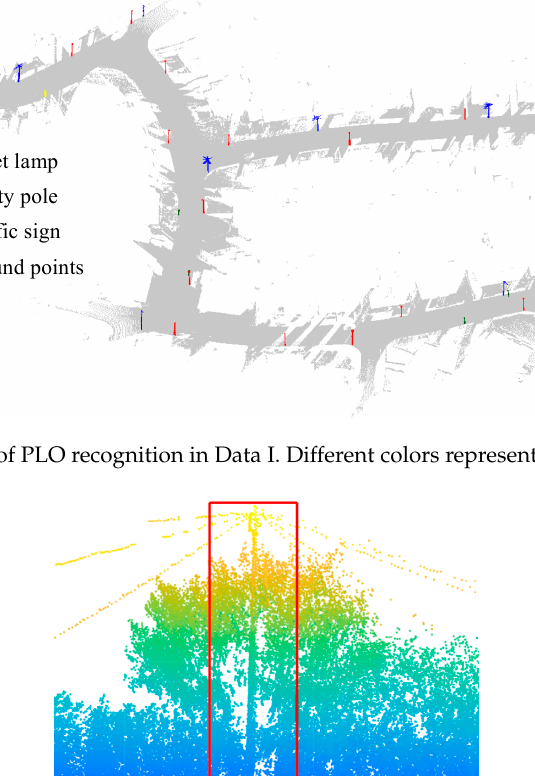
Figure 14. Results of PLO recognition in Data II. Different colors represent different classes.